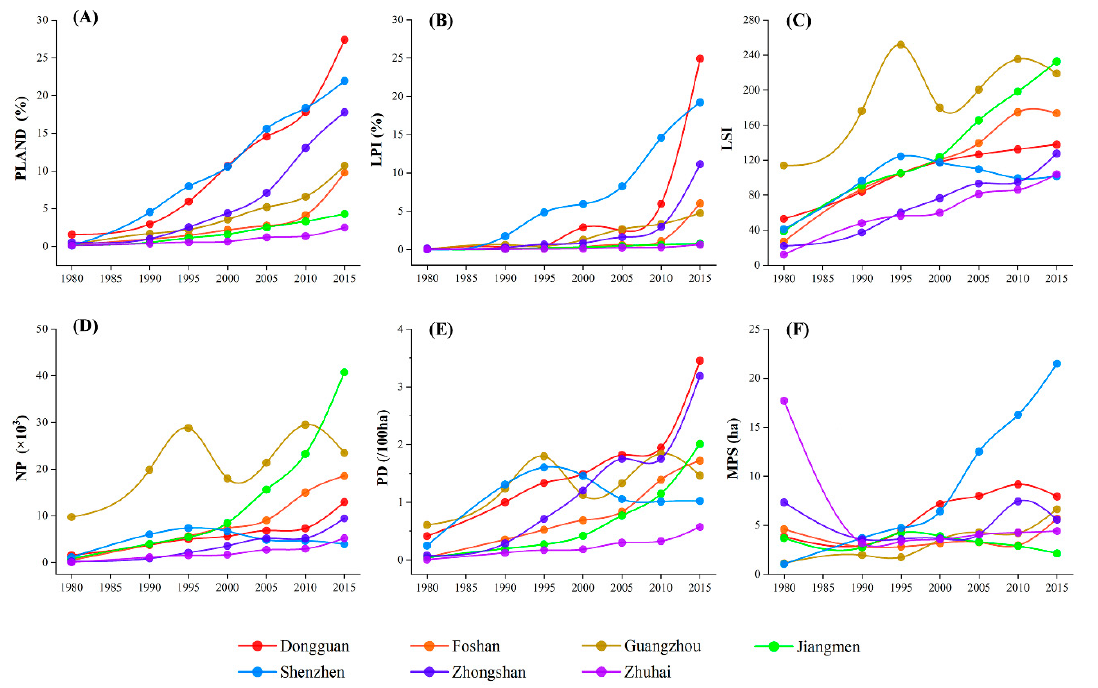
Figure 3. The temporal dynamics of landscape metrics for urban land in seven cities from 1980 to 2015: ( A ) Percentage of Landscape (PLAND) (%), ( B ) Largest Patch Index (LPI) (%), ( C ) Landscape Shape Index (LSI), ( D ) Number of Patches (NP), ( E ) Patch Density (PD) (N/100ha), and ( F ) Mean Patch Size (MPS) (ha).